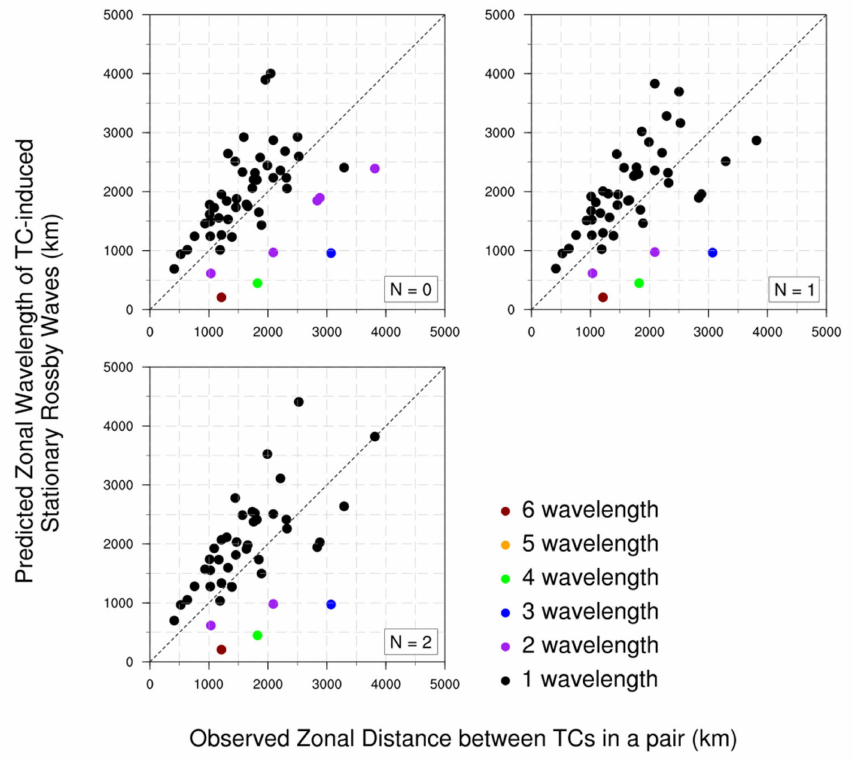
Figure 5. Scatterplot of the observed zonal distances between TCs in the detected pairs and the predicted zonal wavelength of TC-induced Rossby waves computed from the shallow-water